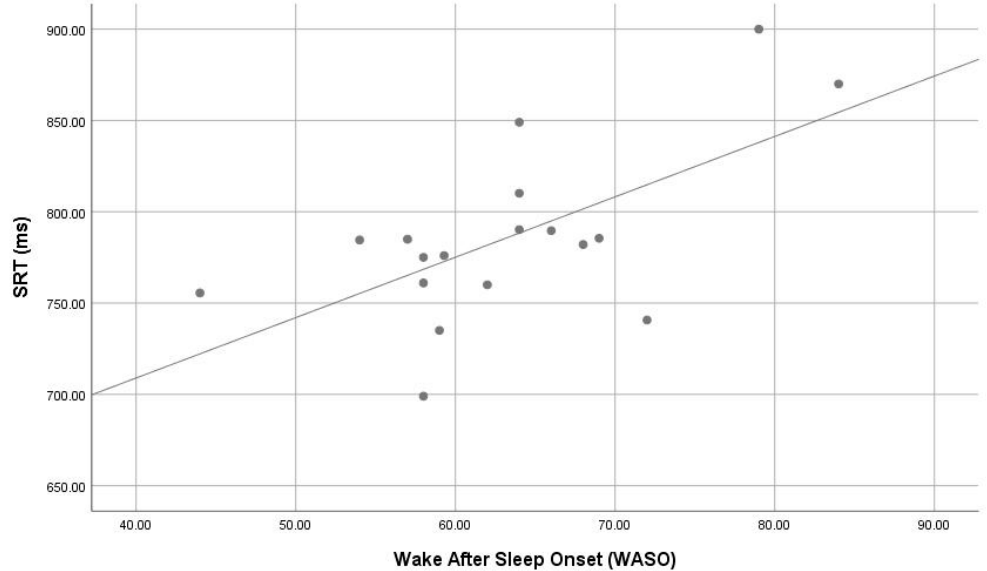
Figure 3. Correlation (r = 0.474, p = 0.047) of sleep anxiety (CSHQ subscale) and simple reaction time (ms) in ASD.